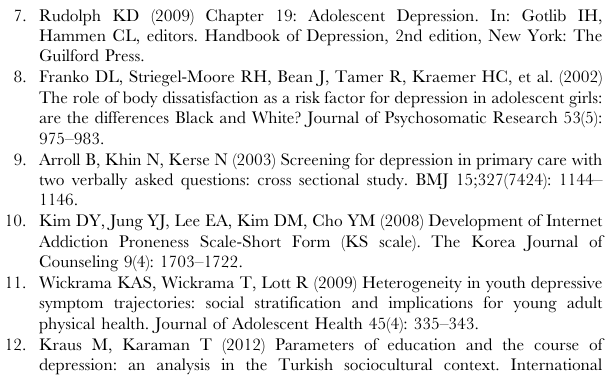
Model 1: adjusted variables include gender, age (in grades), self-rated academic achievement, FAS, parental support, alcohol drinking and smoking volumes, substance abuse, internet addiction, high and moderate level physical activity, weight training, self-rated sleep satisfaction and health status as individual level variables, and schools’ gender type and scale of the area school is located in as school-level variables. Model 2: adjusted variables include those in model 1, with exception of parental support and addition of parental education level